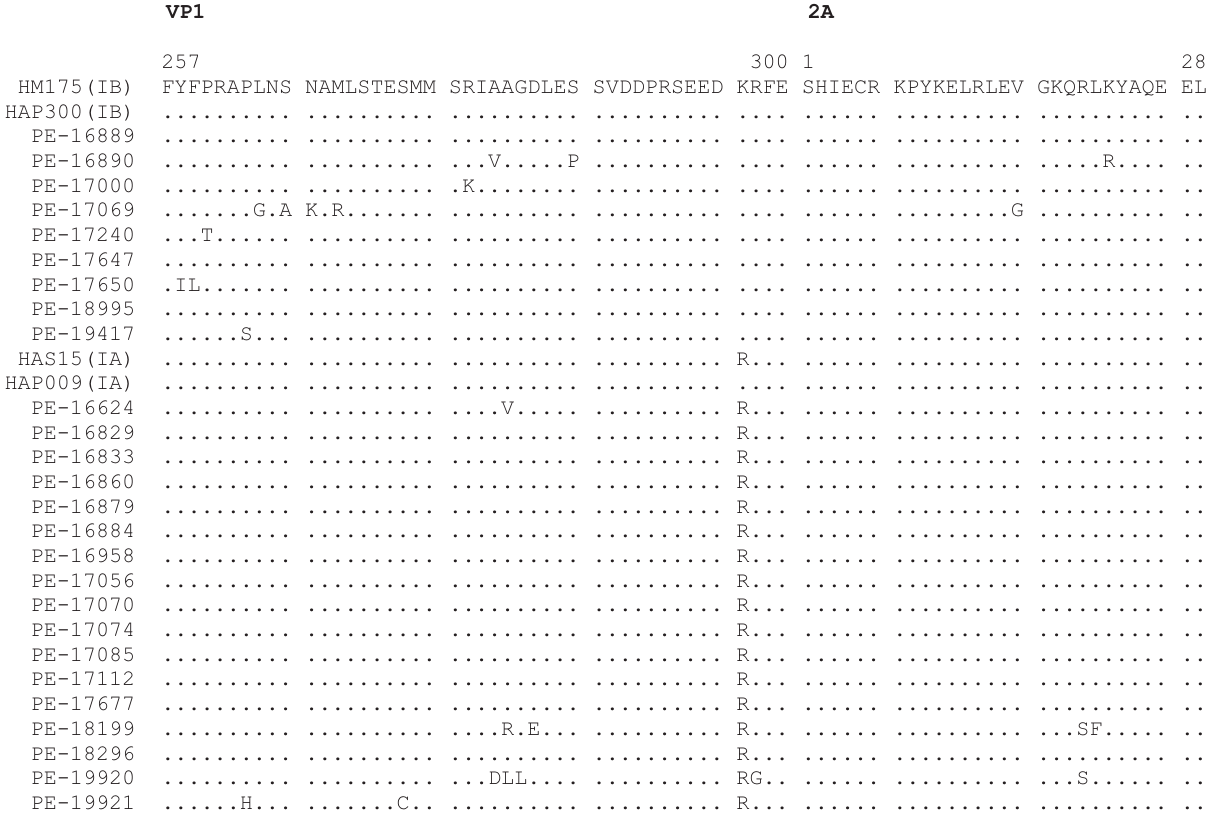
Figure 3. Comparison of the predicted amino acid sequence of the VP1/2A junction of the hepatitis A virus strains